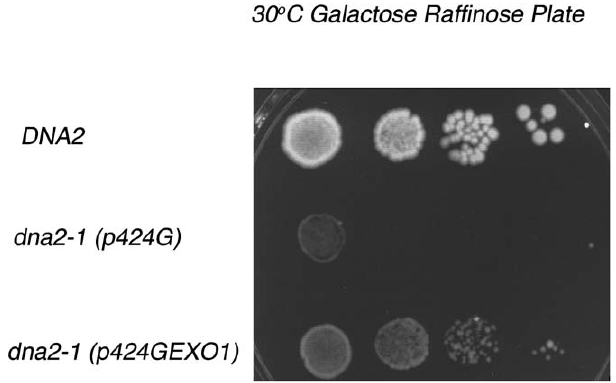
Figure 3. Suppression of dna2 by ExoIp Overexpression Strain W303 dna2–1 was transformed with the plasmids pRS424G and pRS424G-EXO1, an empty plasmid vector and a plasmid expressing